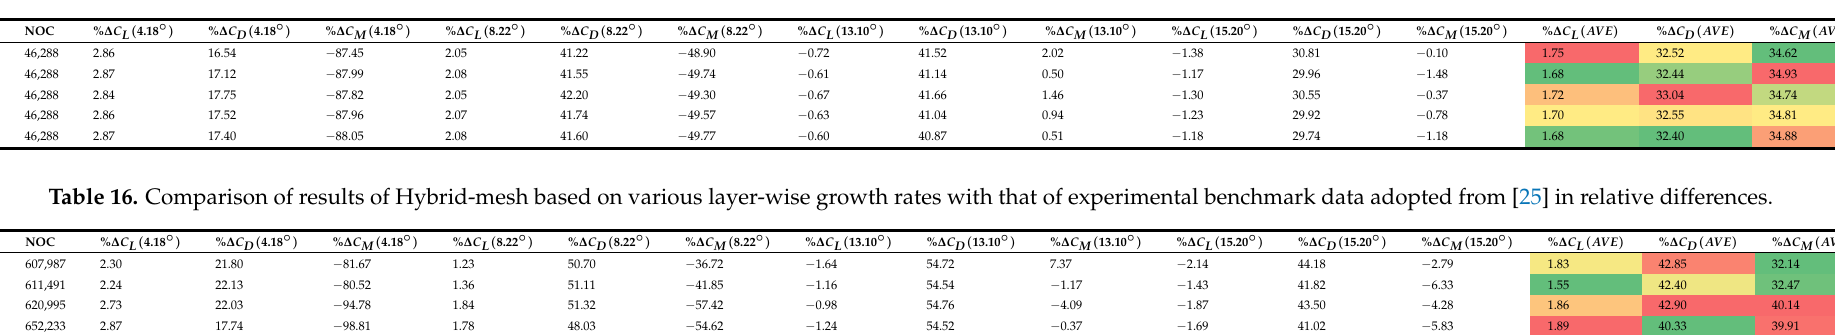
Table 15. Comparison of results of H-mesh based on various layer-wise growth rates that of experimental benchmark data adopted from [25] in relative differences.